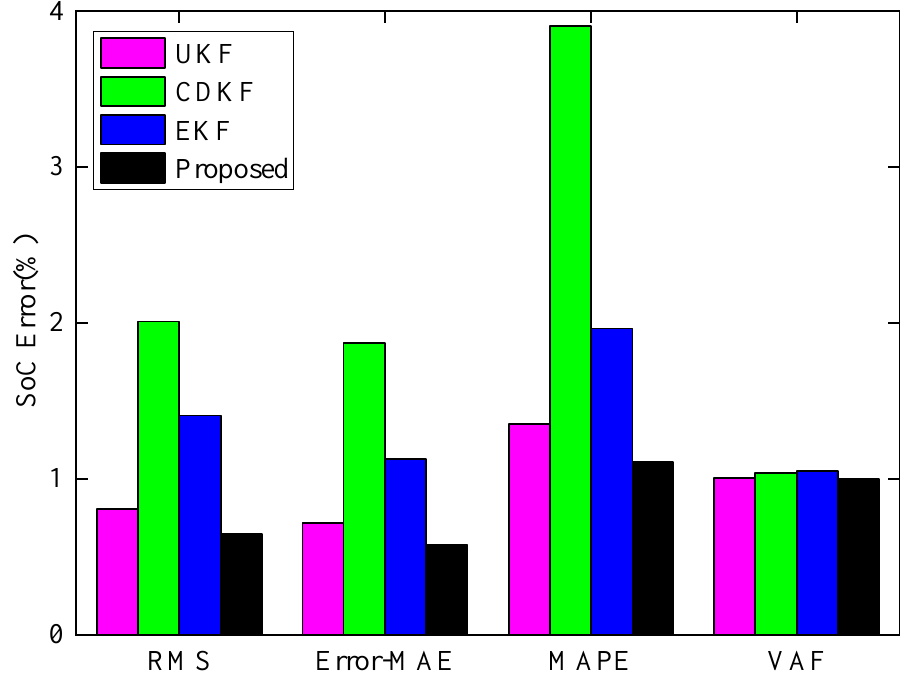
Figure 13. The four evaluation indexes of the initial SoC guess were 0.7 under the FUDS condition. VAF0.00.51.01.52.02.5 Figure 14. The four evaluation indexes of the initial SoC guess were 0.9 under the FUDS condition.